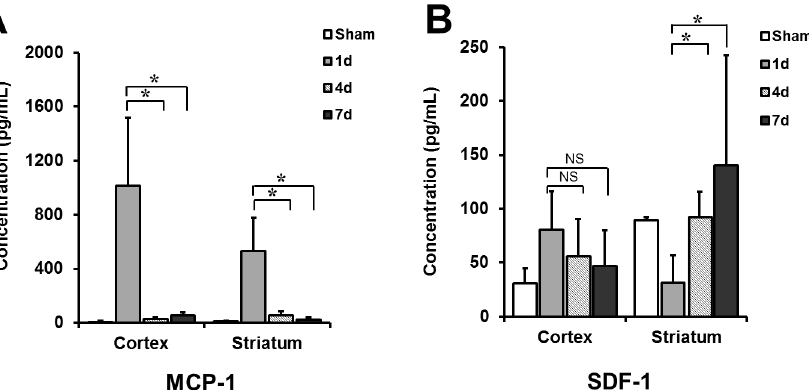
Fig 5. MCP-1 and SDF-1 expression levels in ischemic lesions according to the time after MCAo. (A) Expression level of MCP-1 was higher in brain extracts obtained from both cortex and striatum at 1 day after MCAo than in those at 4 or 7 days after MCAo ( * P < 0.01). (B) In comparison, the SDF-1 concentration was higher at 4 or 7 days after MCAo than the concentration at 1 day after MCAo in striatum ( * P < 0.01). However, there was no difference in the SDF-1 concentration according to the time from MCAo in cortex (n = 4 for each group). MCP-1 indicates monocyte chemotactic protein-1; SDF-1, stromal cell-derived factor-1; MCAo, middle cerebral artery